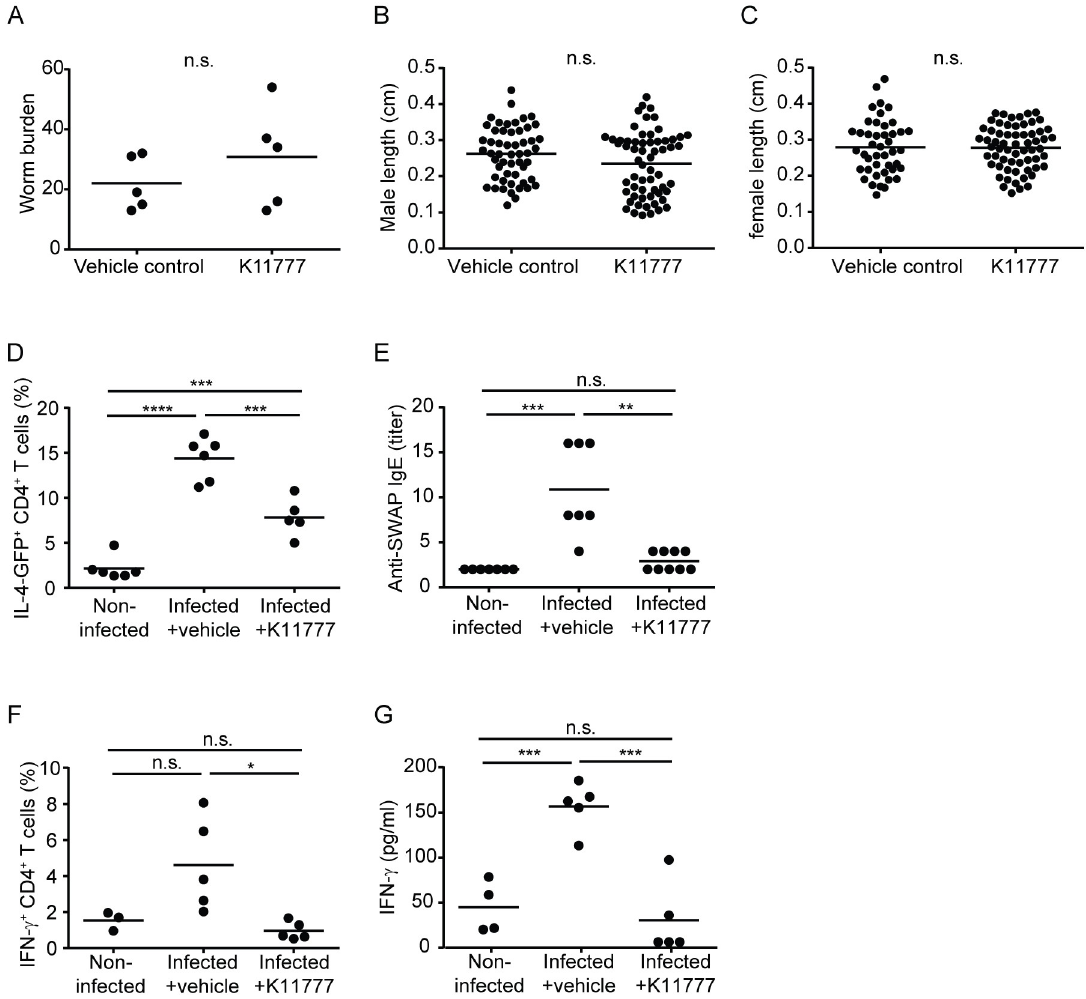
Fig 1. Treatment of mice with the cysteine protease inhibitor, K11777, inhibits T helper responses during pre-patent schistosome infection. S . mansoni -infected 4get IL-4 reporter mice were treated with cysteine protease inhibitor (K11777) or vehicle alone throughout the first 4 weeks of infection. A, parasite burden, B length of male worms, and C, length of female worms in animals treated with K11777 or vehicle alone, at 4 weeks post infection. D, frequency of IL-4-GFP + CD4 + T cells in spleens of non-infected control mice, and vehicle-treated and K11777-treated infected mice at 4 weeks post infection. E, Plasma titers of anti-SWAP IgE in non-infected control mice, and vehicle-treated and K11777-treated infected mice at 4 weeks post infection. F, frequency of IFN- γ + CD4 + T cells in spleens of non-infected control mice, and vehicle-treated and K11777-treated infected mice at 4 weeks post infection. G, SWAP- stimulated IFN- γ secretion by splenocytes from non-infected control mice, and vehicle-treated and K11777-treated infected mice at 4 weeks post infection. n.s., P > 0.05; � , P < 0.05; �� , P < 0.01; ��� , P < 0.001; ���� , P <